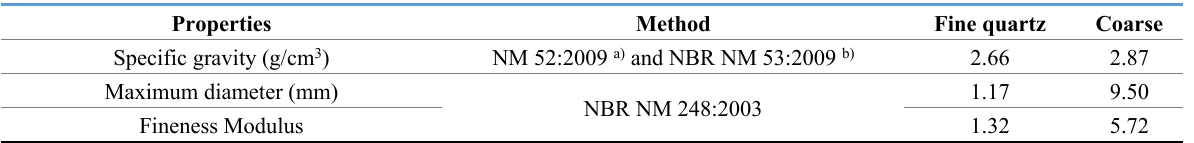
Table 3. Physical characterization of aggregates and methods